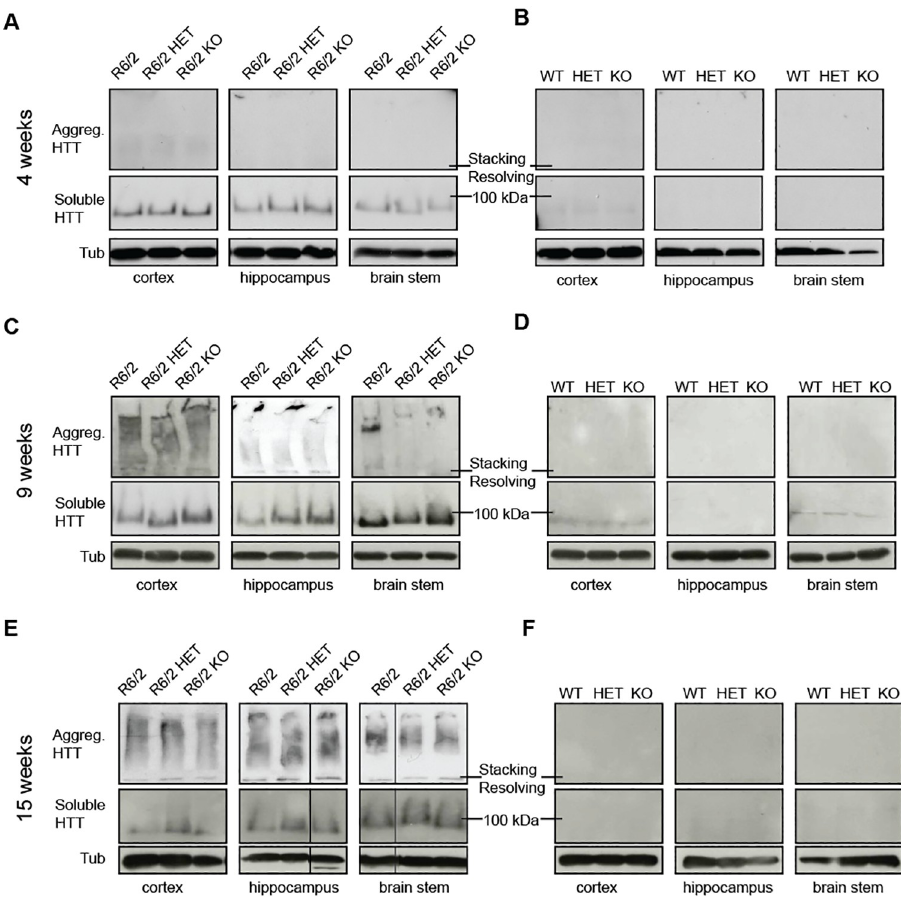
Fig 5. Levels of soluble mHTT in various brain regions at 4, 9 and 15 weeks of age. Representative western blots from cortex, hippocampus and brain stem of ( A–B ) 4, ( C–D ) 9 and ( E–F ) 15 week old wild type (WT), Sirt2 HET (HET), Sirt2 KO (KO), R6/2, Sirt2 HETxR6/2 (R6/2 HET) and Sirt2 KOxR6/2 (R6/2 KO) mice probed with an anti- mHTT antibody (S829) and tubulin (Tub) as loading control. Faint signal was visible in panels B and D upon longer exposure; this is non-specific as these data were obtained using samples from WT animals. All samples were run on the same gel. Black lines indicate where lanes are not contiguous.